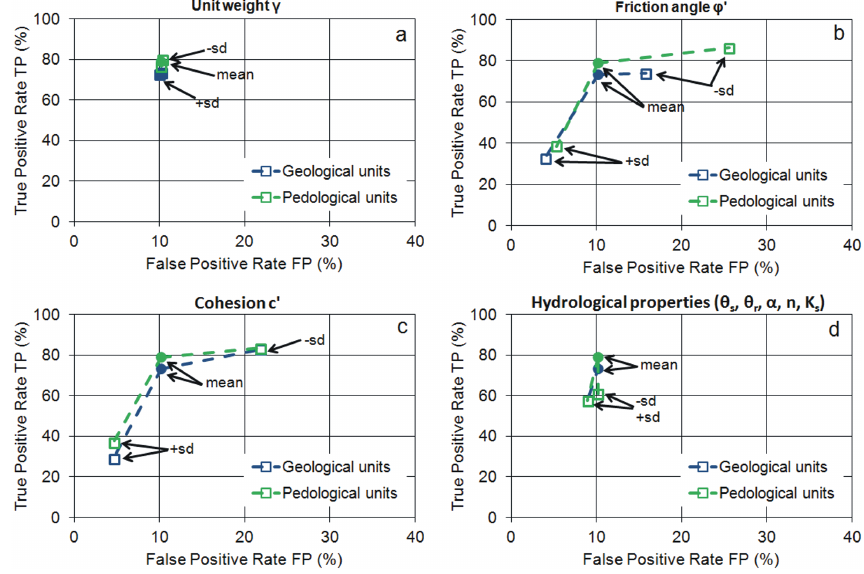
Figure 14. Effects of different soil input data on FP and TP indexes obtained by modelling with TRIGRS-unsaturated, considering the values in Table 5 for geological and pedological zoning: (a) unit weight, (b) friction angle, (c) cohesion and (d) hydrological properties.